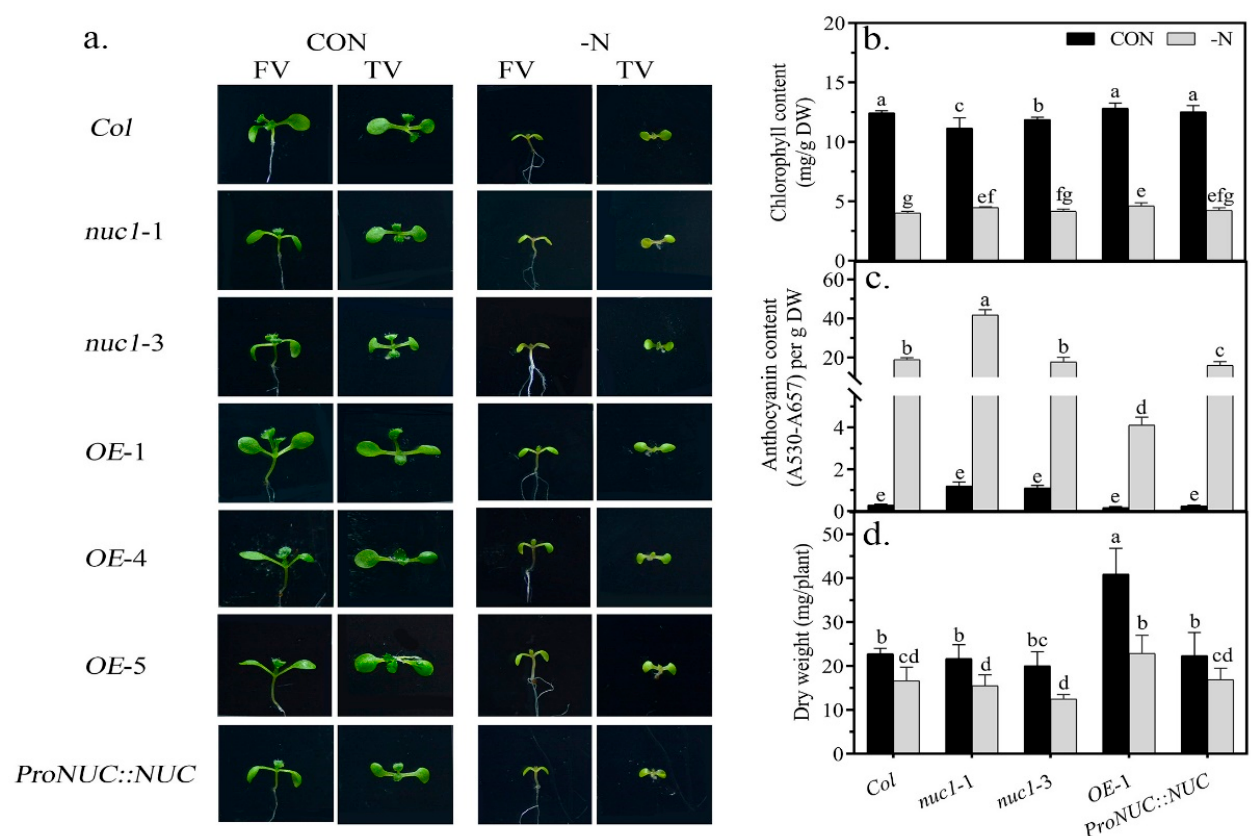
Figure 2. Overexpression of NUC improves plant growth under both N-sufficient and N-deficient conditions and increases resistance to N deficiency stress. ( a ): Front view (FV) and top view (TV) show the leaf phenotype of 10-day-old seedlings, in which 4-day-old normal-grown seedlings were transplanted to media with (control, CON) and without (N deficiency, -N) nitrogen for 6 days. ( b – d ): Chlorophyll content, anthocyanin content, and dry weight of whole plants cultured hydroponically for 45 days, in which 30-day-old seedlings were transferred to hydroponic media with (CON) and without (-N) nitrogen, respectively, for 14 days. Values are the mean ± SDs ( n ≥ 3). Different letters indicate significant difference between treatments according to Duncan’s multiple range test at p < 0.05.